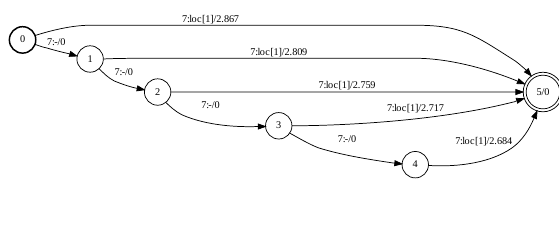
Fig. 5. The Weighted Finite-State Transducer for the first 5 time samples in the loc model. The lowest path (with 5arcs) corresponds to the first part in Fig. 4 which is bound to the right by the dashed line labeled d 1 . While the nodes only mark the steps in time, the arcs contain the input states, output labels, and the corresponding weight, which in this case is the negative log probability of the du- ration